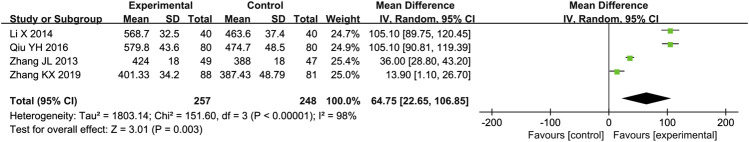
Forest plot of 6-MWD.